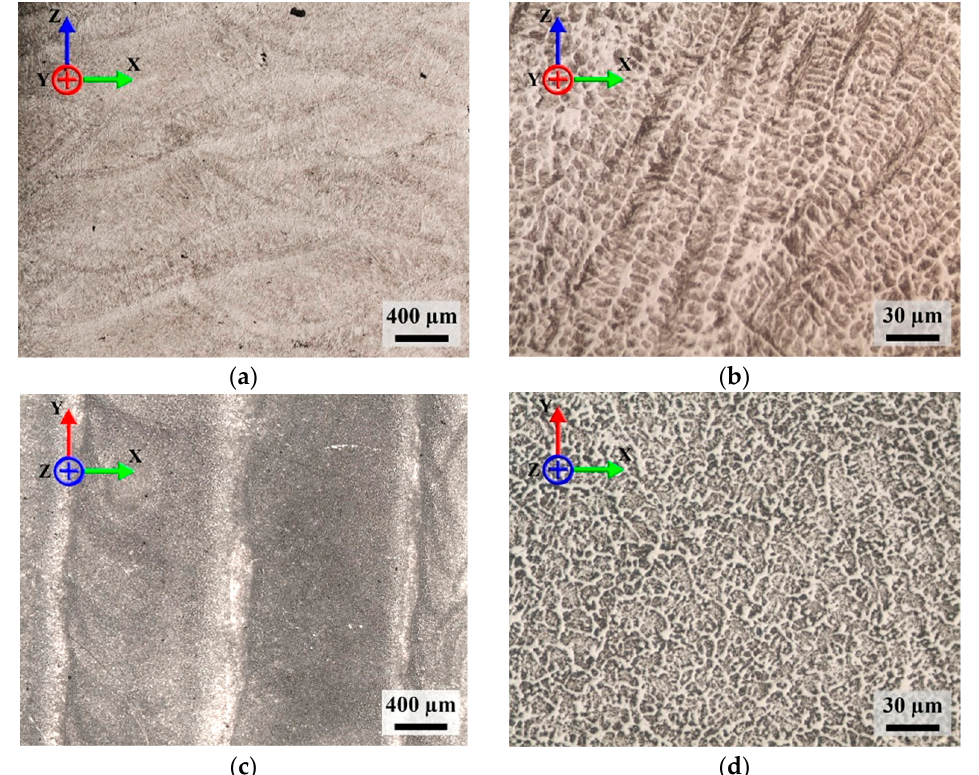
( d ) Figure 5. Microstructure of the original H13 steel sample L-DED manufactured without US, where ( a ) and ( b ) are the perpendicular direction ( Y ), in line with the building direction, and ( c ) and ( d ) are the longitudinal direction ( X ).